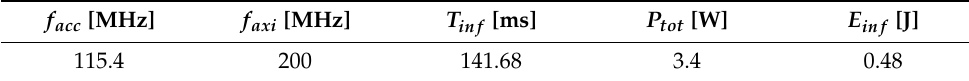
Table 3. Measured results summary for XCZU7EV system implementation.